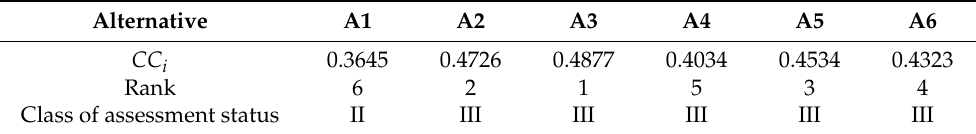
Table 9. Ranking of offshore wind farms planned in Poland in the coming years.